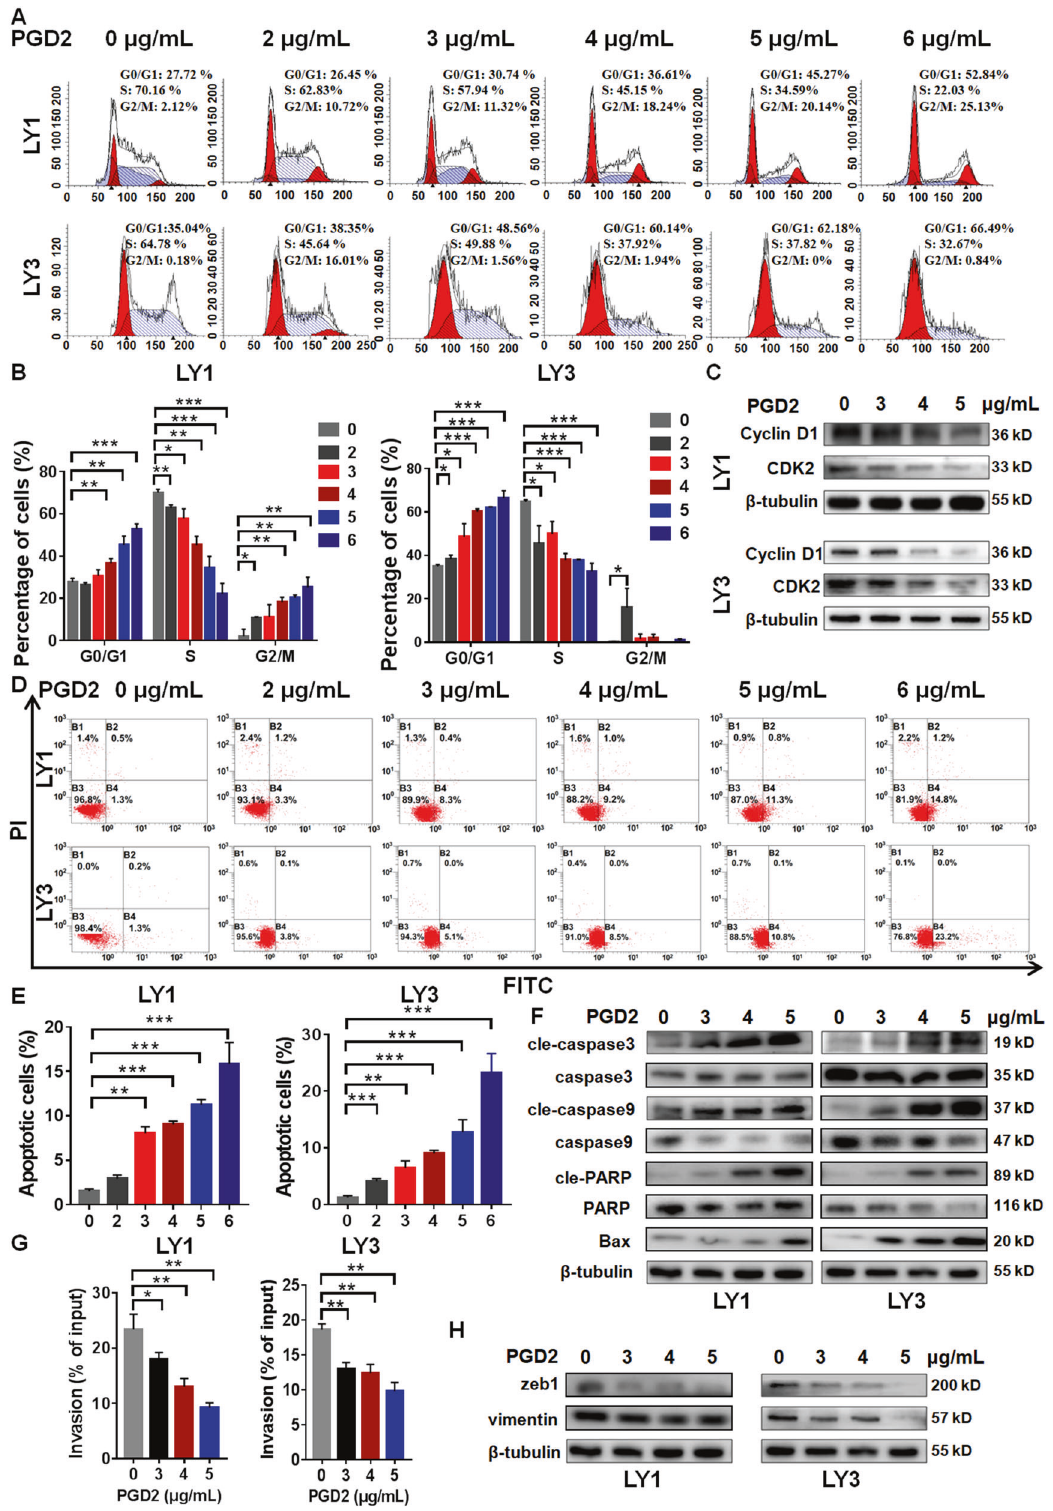
Fig. 3 High-concentration PGD2 regulated the cell cycle, apoptosis, and invasion of DLBCL cells. After the treatment with high- concentration PGD2 for 48 h, A – C High-concentration PGD2 induced G0/G1 cell cycle arrest and decreased the expression of Cyclin D1 and CDK2 in DLBCL cells. D – F High-concentration PGD2 induced cell apoptosis ( D representative images and E statistic results) and in fl uenced the expression of apoptosis associated proteins. G , H High-concentration PGD2 suppressed cell invasion and the expression of zeb1 and vimentin. Data are shown as the mean ± SD. * p < 0.05; ** p < 0.01; *** p < 0.001.